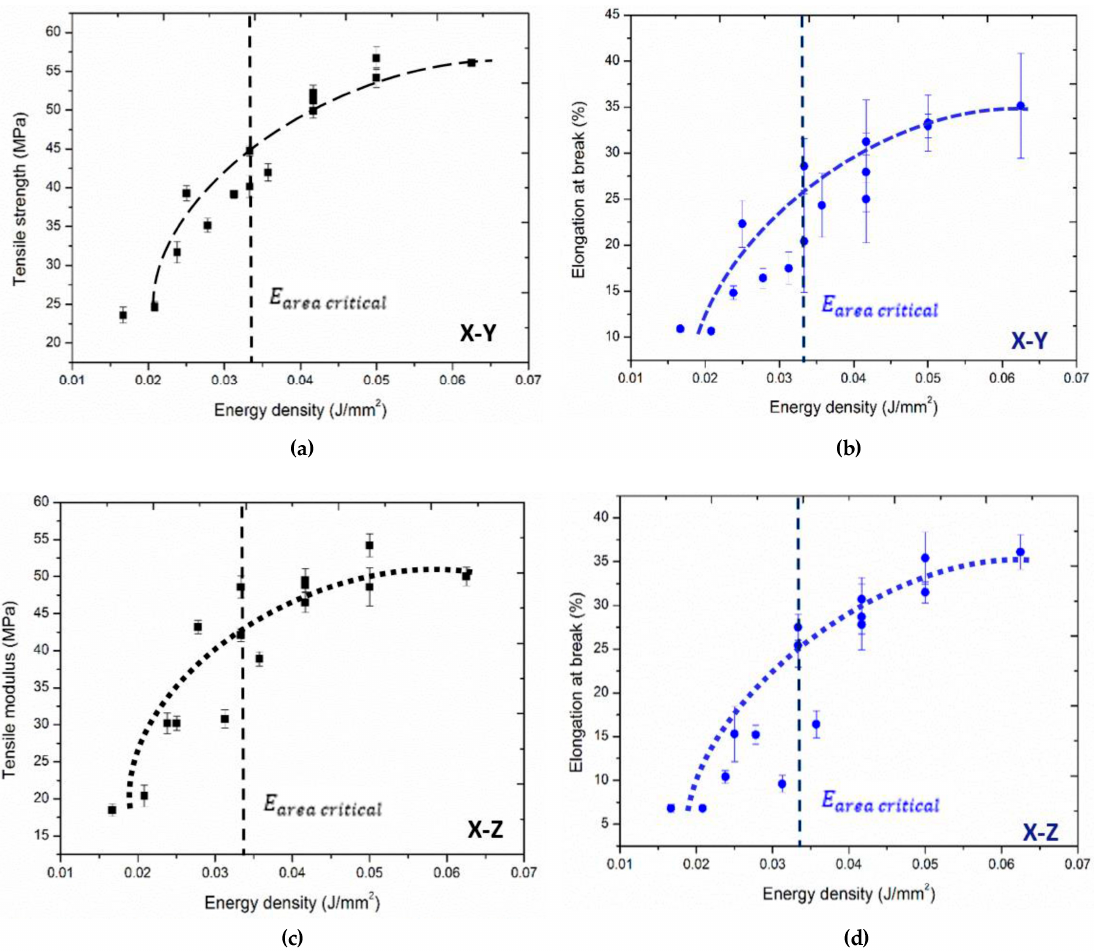
Figure 8. Energy density influences on ( a ) tensile strength and ( b ) elongation at break of specimens in the X – Y plane; ( c ) tensile strength and ( d ) elongation at break of specimens in the X – Z plane.